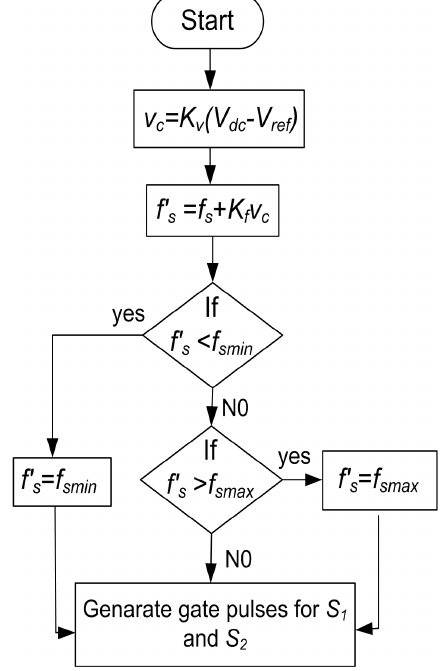
Figure 5. Flow chart for frequency